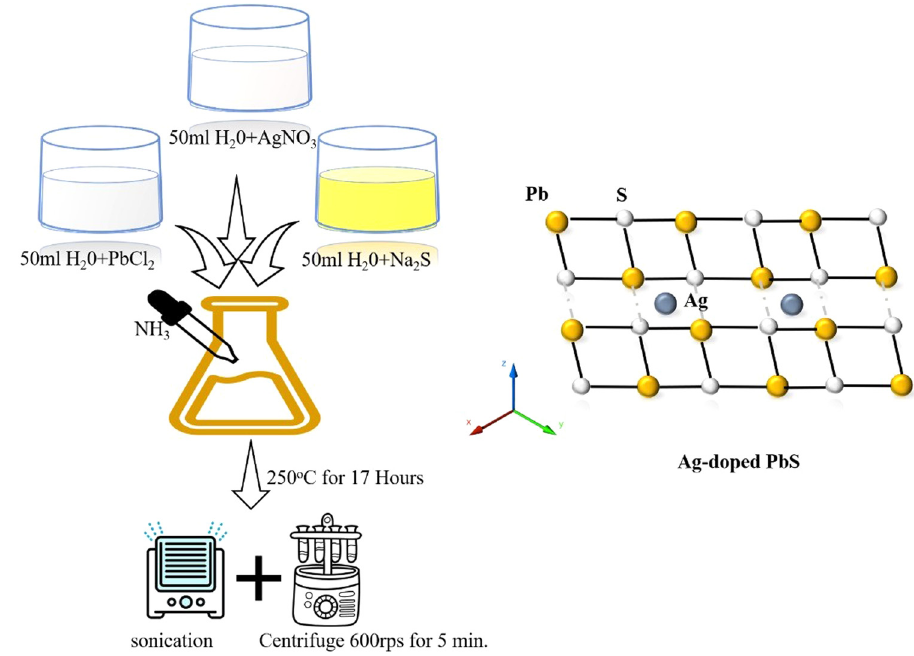
Figure 1: Experimental diagram of sample preparation of pure PbS and Ag:PbS at di ff erent